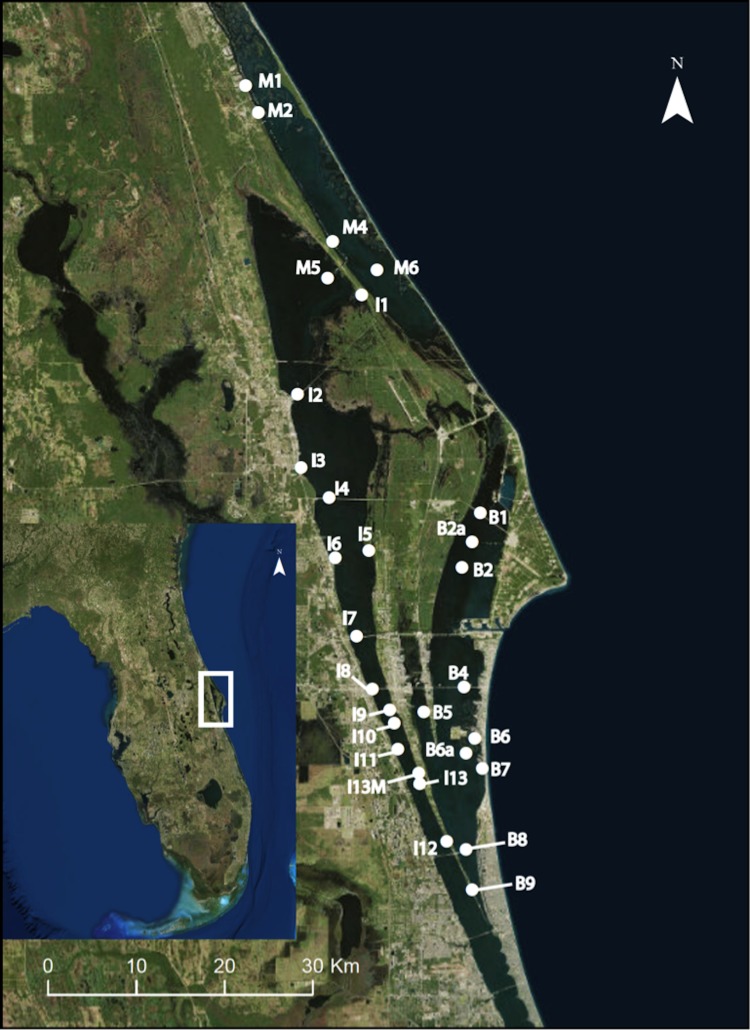
Map of 29 permanent monitoring sites established in the three sublagoons (Banana River [B], Indian River Lagoon [I], and Mosquito Lagoon [M]) of the Northern IRL of central Florida (inset map).Map data: Google, SIO, NOAA, U.S. Navy, NGA, GEBCO, and Landsat/Copernicus.